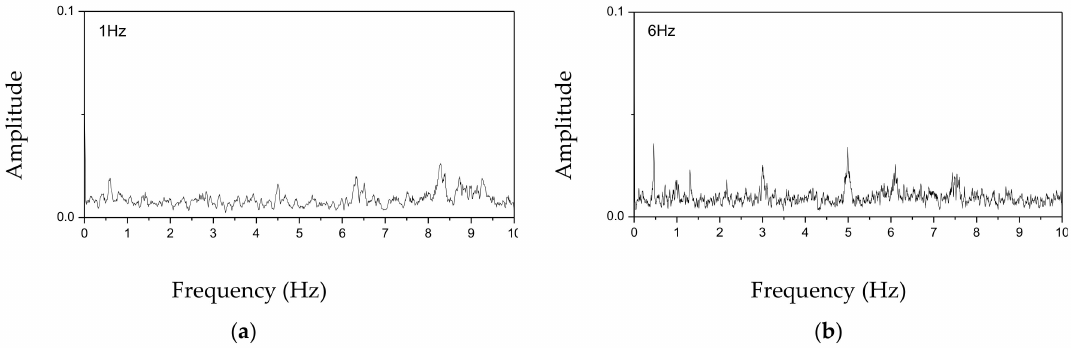
Figure 6. Analysis results of representative Y -axis data. ( a ) A representative 1Hz measuring section was analyzed as white noise; ( b ) a representative 6Hz measuring section was analyzed as white